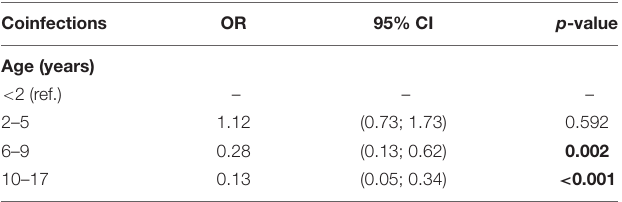
TABLE 5 | Bivariate logistic model for the risk of coinfections by age group. Coinfections OR 95% CI p -value Age (years) < 2